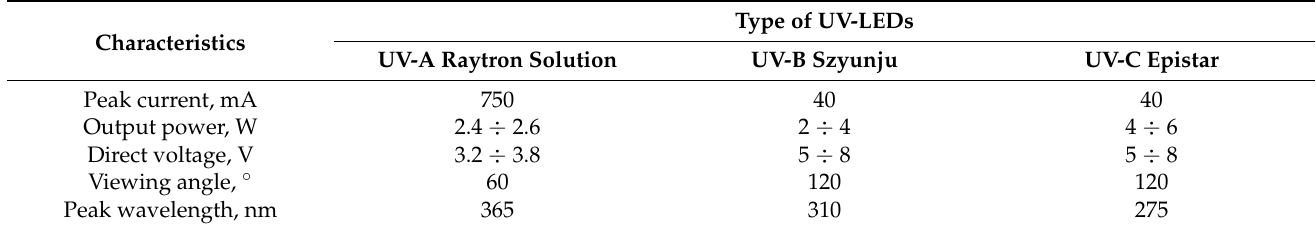
Table 2. Characteristics of